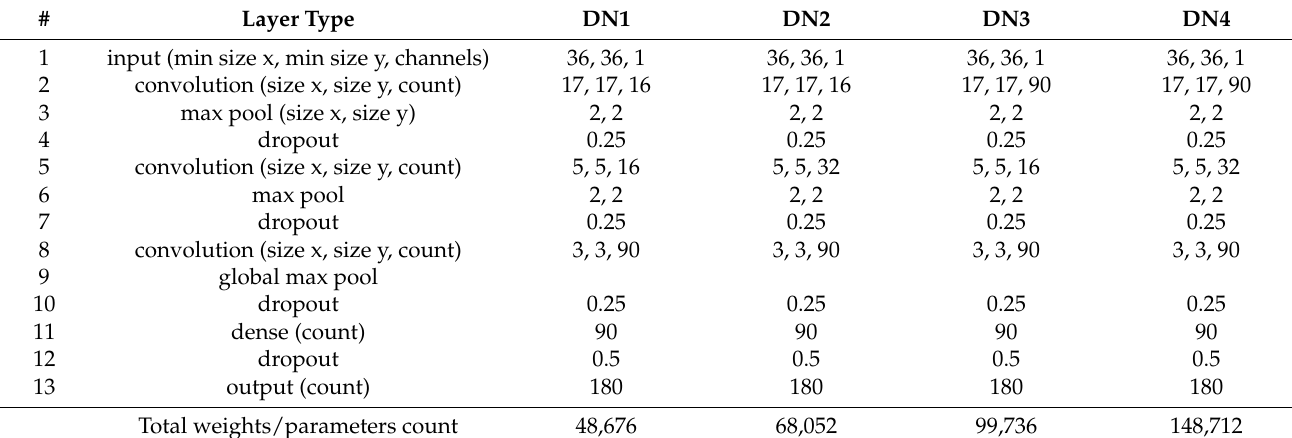
Table 2. The first four deep CNN architectures.